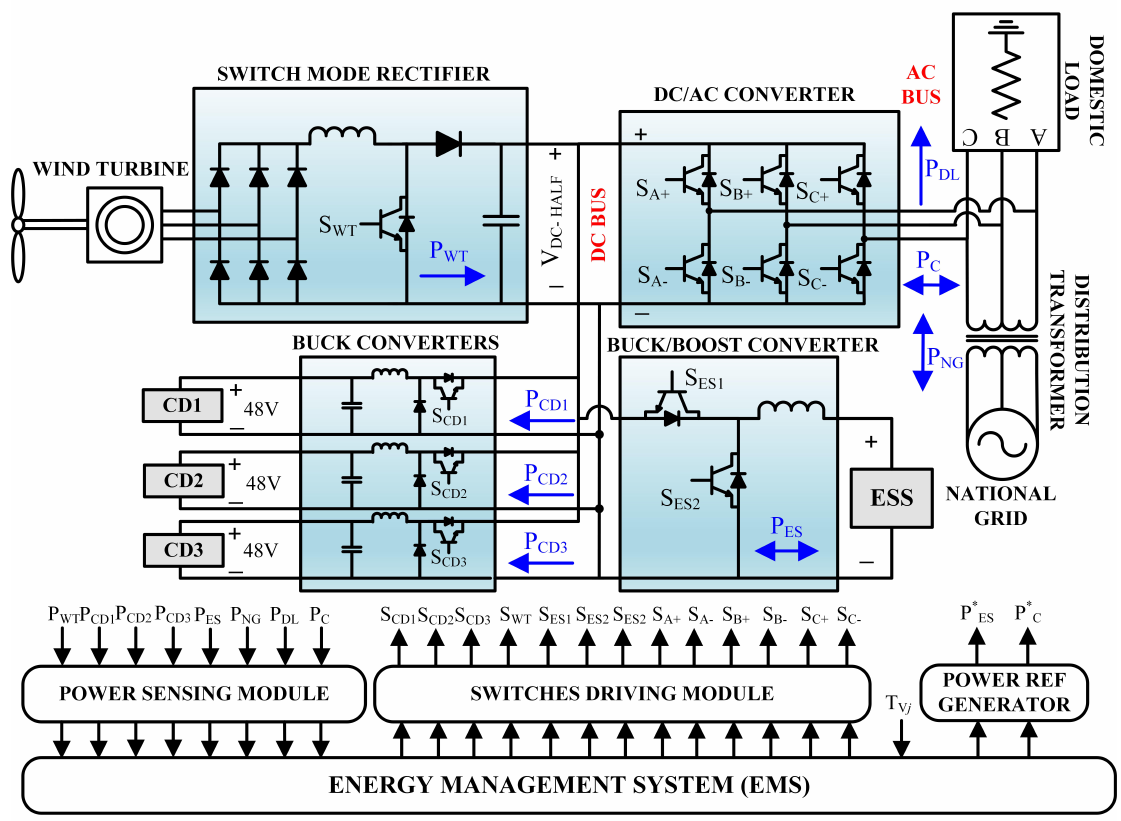
Figure 1. Detailed structure of proposed charging station